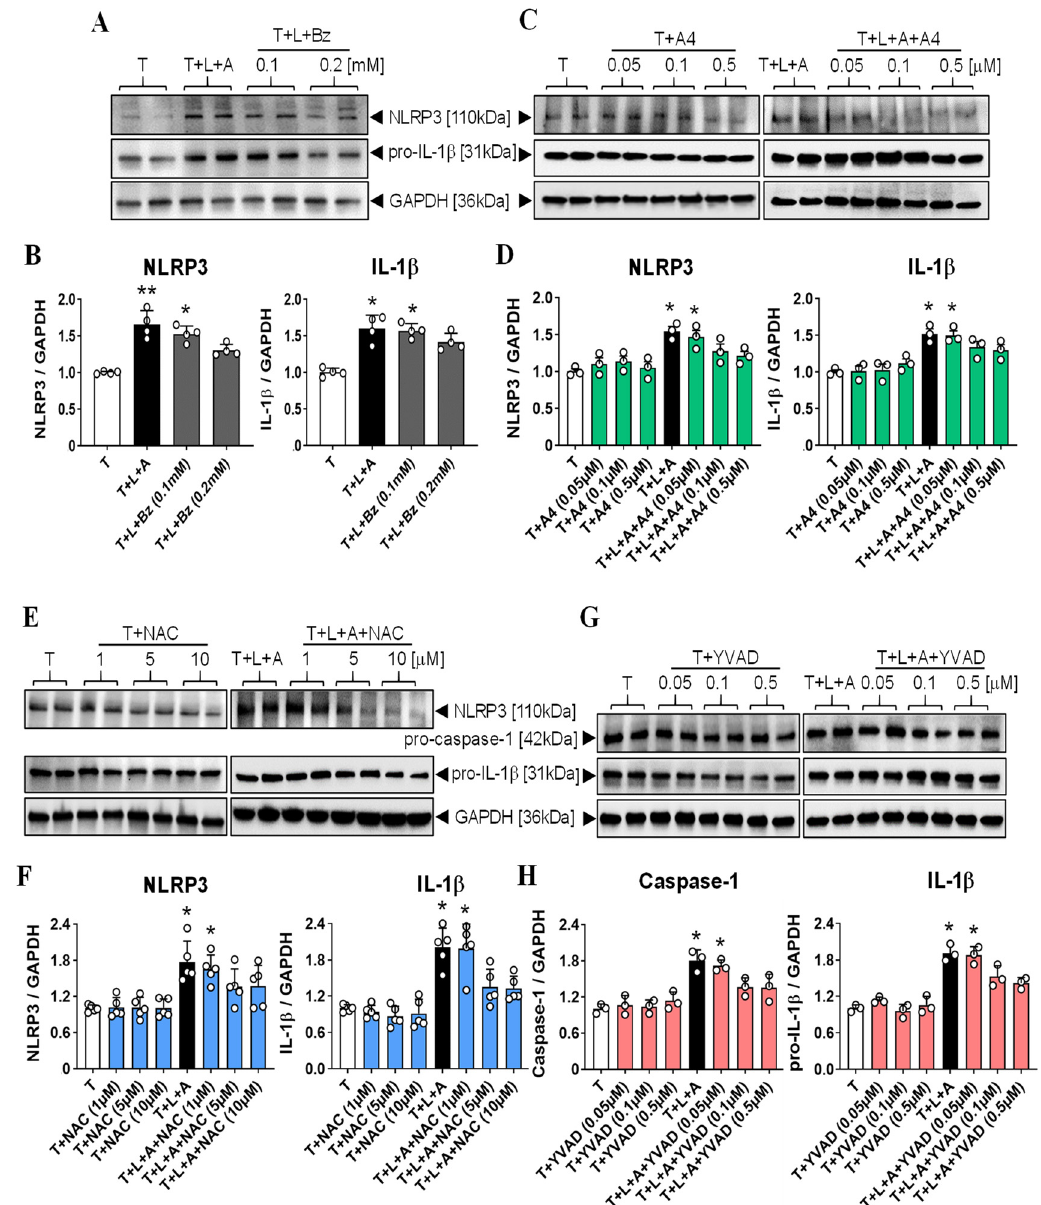
Figure 2. Determination of the optimal dose of T+L+Bz-ATP (Bz) that stimulated NLRP3 and pro- IL-1 β to a similar extent as T+L+A (5 mM), the and optimal dose of the P2X7R inhibitor (A4), the ROS inhibitor (NAC), and the caspase-1 inhibitor (YVAD) that did not affect the T+L+A-stimulated increase in NLRP3 or pro-caspase-1 (YVAD) or pro-IL-1 β expression, when administered to HCMFs alone, after 8 h. ( A ) Representative Western blots of NLRP3 and pro-IL-1 β expression from T-, T+L+A (5 mM)- or T+L+Bz (0.1 or 0.2 mM)-stimulated HCMFs after 8 h in culture. ( C , E , G ) Representative Western blots of NLRP3 and pro-IL-1 β expression show the effects of T- vs. T+L+A-stimulation of HCMFs treated with increasing doses of A4 (0.05–0.5 µM) ( C ), NAC (1–10 µM) ( E ), or YVAD (0.05–0.5 µM) ( G ) for 8 h. ( B , D , F , H ) Also shown are the mean ± SEM of each end point measured from each treatment group studied, corrected for GAPDH (house-keeping protein) loading, and expressed relative to the value in the T-stimulated group, which was expressed as 1 in each case, from n = 3–5 separate experiments conducted in duplicate. The individual data sets for each group are represented by the white circles within each set of bar graphs. * p < 0.05, ** p < 0.01 compared with the T alone group.